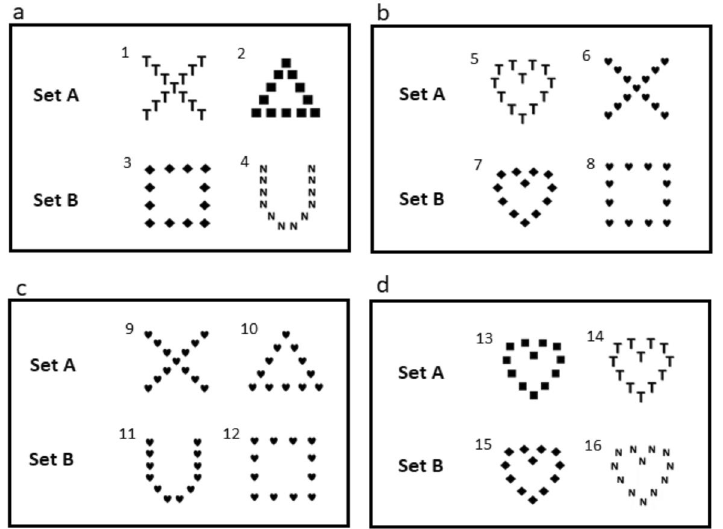
Figure 2. Sets of symbols, with ( a) showing the base symbols the dogs were trained to discriminate: symbols 1 and 3 were the rewarded symbols, and 2 and 4 were the non-rewarded symbols. ( b) The conflict task symbols, symbol 5 and 7 indicate local choices and 6 and 8 indicate global choices. ( c) Symbols used to determine discrimination at the global level only (symbol 9 and 12 are correct), and ( d) shows symbols for assessing discrimination at the local level only (symbol 14 and 15 are